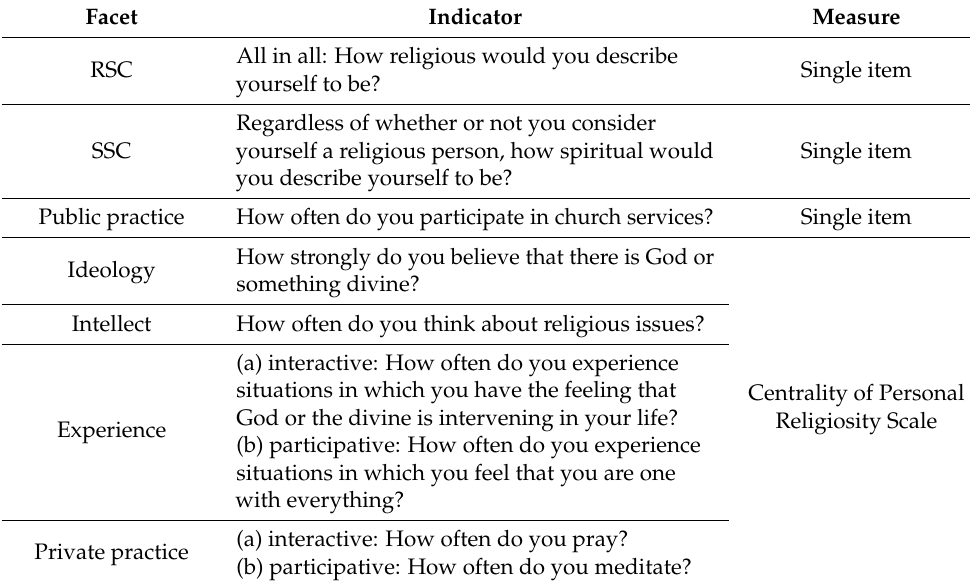
Table 3. Indicators for the Measurement of Religiosity and